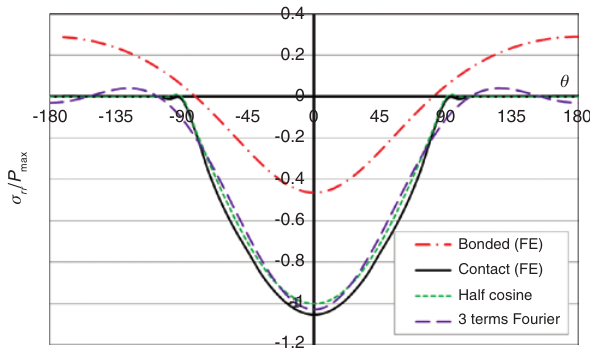
Figure 4: Simplified load distribution profiles along the joint interface.